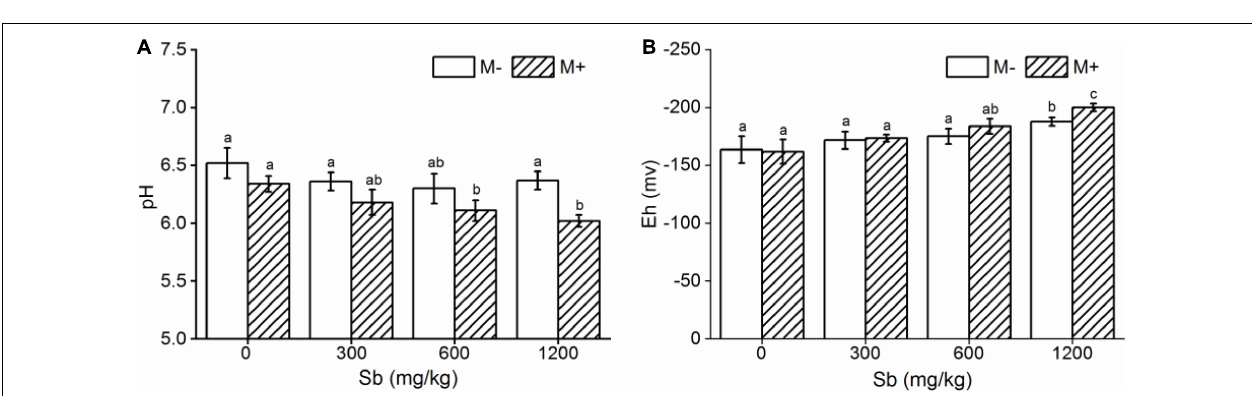
FIGURE 4 | Effects of AMF on Sb concentrations of rice. (A) Roots Sb concentration, (B) stems Sb concentration, (C) leaves Sb concentration, (D) grain Sb concentration. Error bar was calculated from three parallel samples. Error bars sharing no common letter indicate that Sb concentration are significantly different at P < 0.05 level for treatments. The data are means ± SDs ( n =